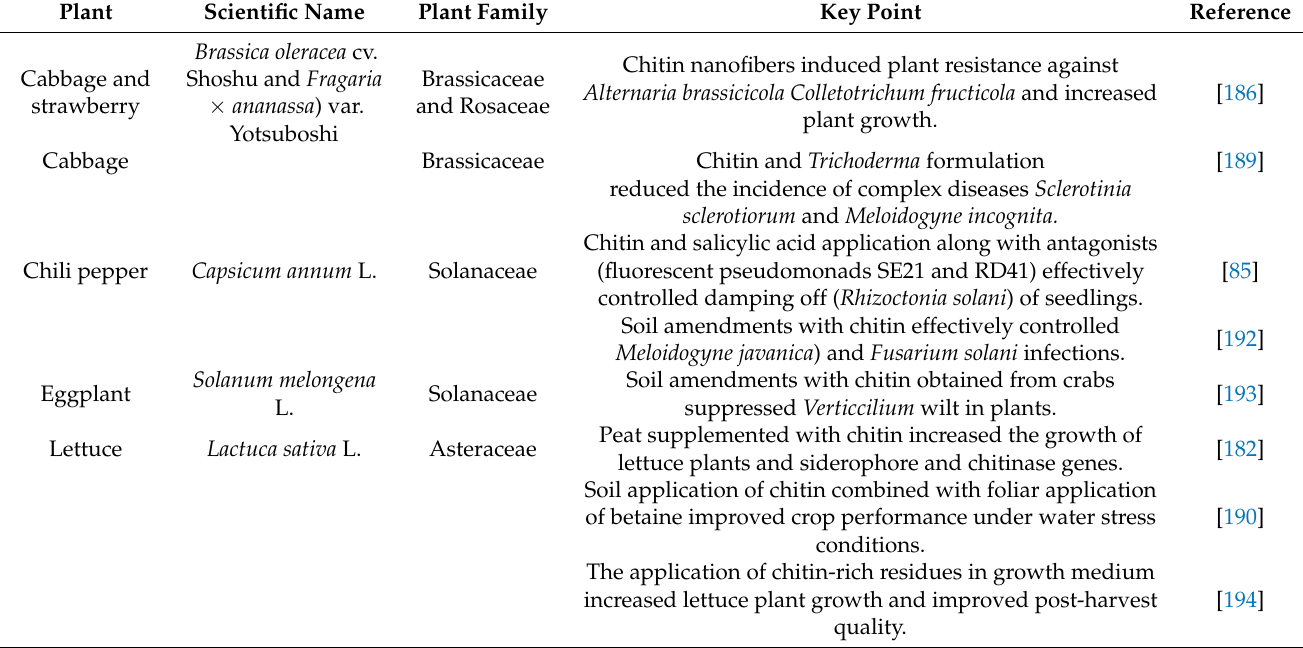
Table 2. The effects of chitin on vegetable